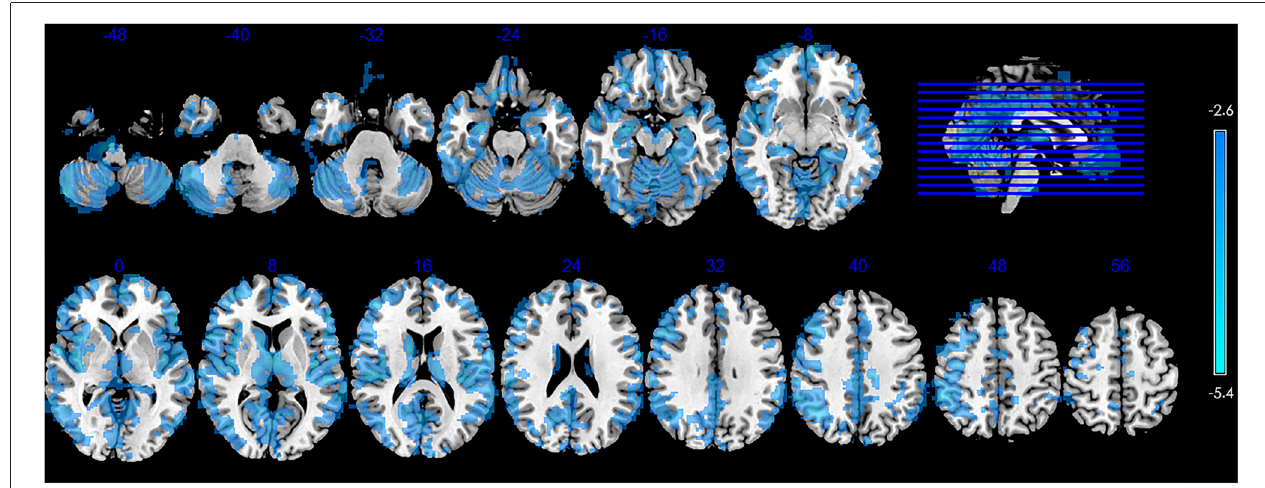
FIGURE 1 | Significant between-group differences in CBF between control subjects and those with SVCI contain the bilateral cerebral cortex (the frontal, parietal, temporal, occipital and insular lobe), periventricular (PV) gray matter (GM), basal ganglia/thalamus, brainstem and cerebellum. The SVCI group showed decreased CBF widespread in the brain. ( p < 0.05, AlphaSim-corrected). The t -score bars are shown on the right. Blue indicates SVCI < controls. Note: the left part of the figure represents the patient’s right side. SVCI, subcortical vascular cognitive impairment; CBF, cerebral blood flow.